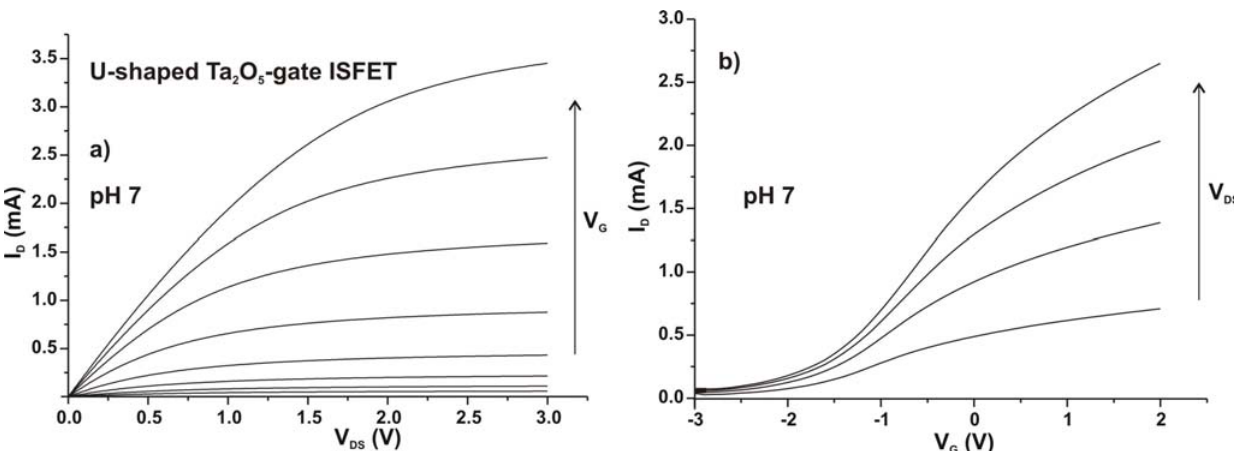
O -ISFET (layout (a) in 2 5